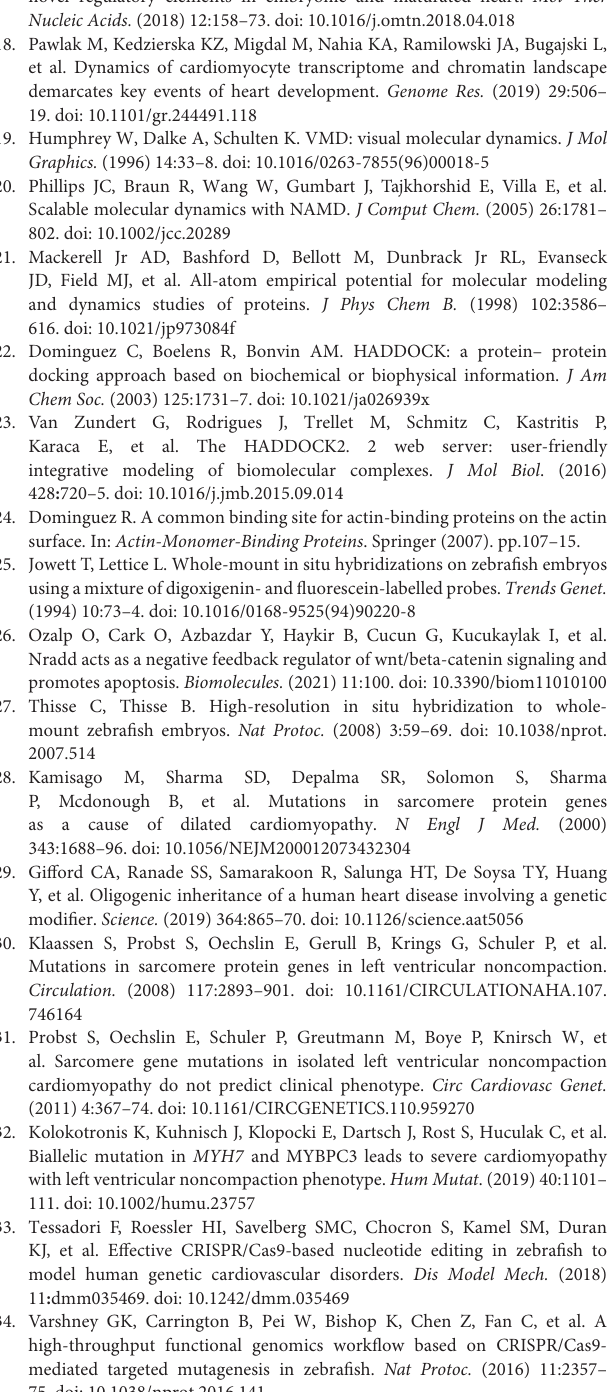
Supplementary Figure 2 | Expression patterns of myh superfamily members during zebrafish cardiac development in 24, 48, and 72 hpf. Supplementary Table 1 | Primer sequences for MYH7 targeting sgRNA, scrambled control RNA, MYH7 sequencing and RNA probes.